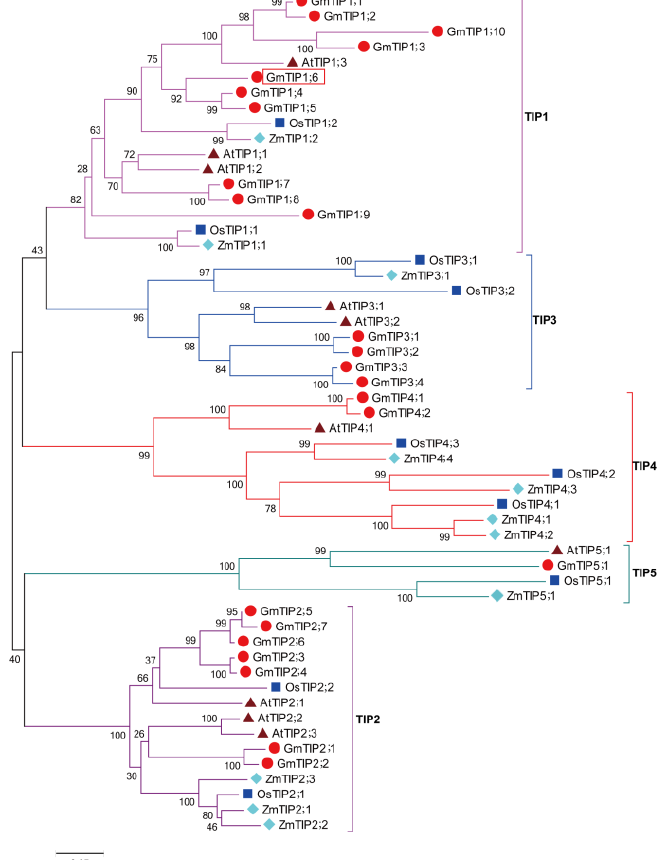
Figure 1. Phylogenetic relationship of GmTIP1;6 from soybean, Arabidopsis , rice and maize TIPs. TIPs were divided into five groups (TIP1, TIP2, TIP3, TIP4, and TIP5), which were marked with different colors. Soybean TIPs (GmTIPs), Arabidopsis TIPs (AtTIPs), rice TIPs (OsTIPs), and maize TIPs (ZmTIPs) were marked with red spots, purple triangles, dark blue squares, and light blue diamonds, respectively. GmTIP1;6 was marked with the red box.